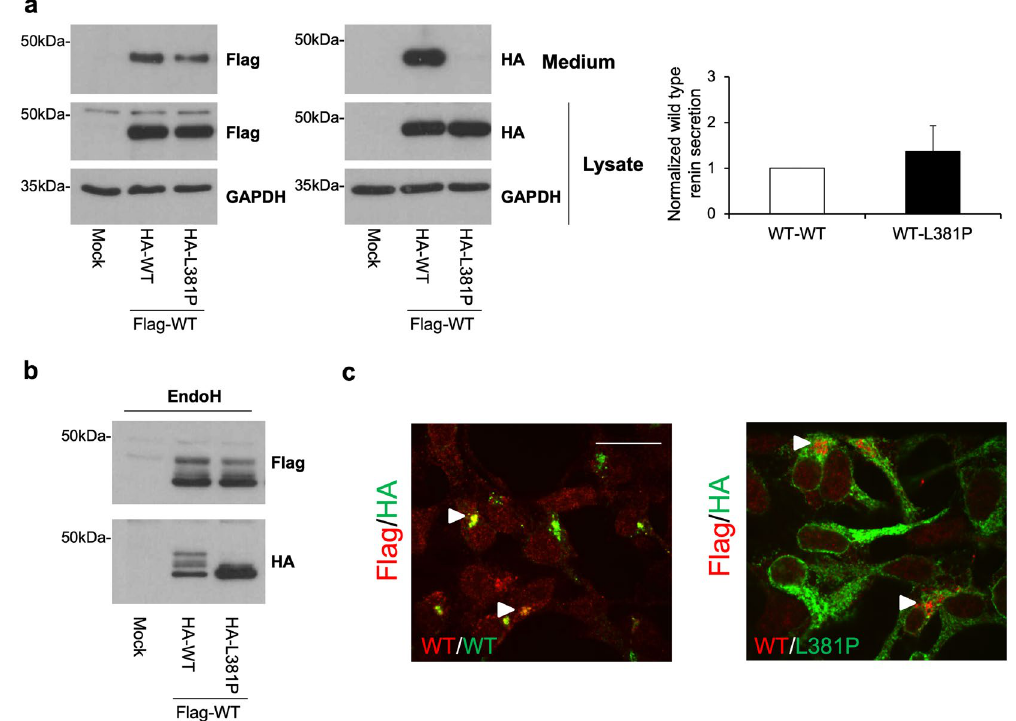
Figure 4. The L381P renin isoform does not exert a dominant negative effect on trafficking of wild type renin. (a) Western blot analysis showing Flag- and HA-tagged renin isoforms in lysate and conditioned medium of stably transfected HEK cells. GAPDH is shown as a loading control. Quantification of secreted Flag-tagged wild type isoform normalized to Flag-tagged wild type protein present in cell lysate is shown. Data are expressed as mean ± s.d. (n = 3 independent experiments). (b) Western blot analysis showing Flag- and HA-tagged renin in HEK lysates after treatment with EndoH. Full-length blots ( a,b ) are presented in Supplementary Fig. S3. (c) Immunofluorescence analysis showing merged picture of Flag- and HA-tagged renin in red and green respectively. Bar = 40 μ m. Cellular localization of wild type renin is not affected by co-expression with ER- retained L381P